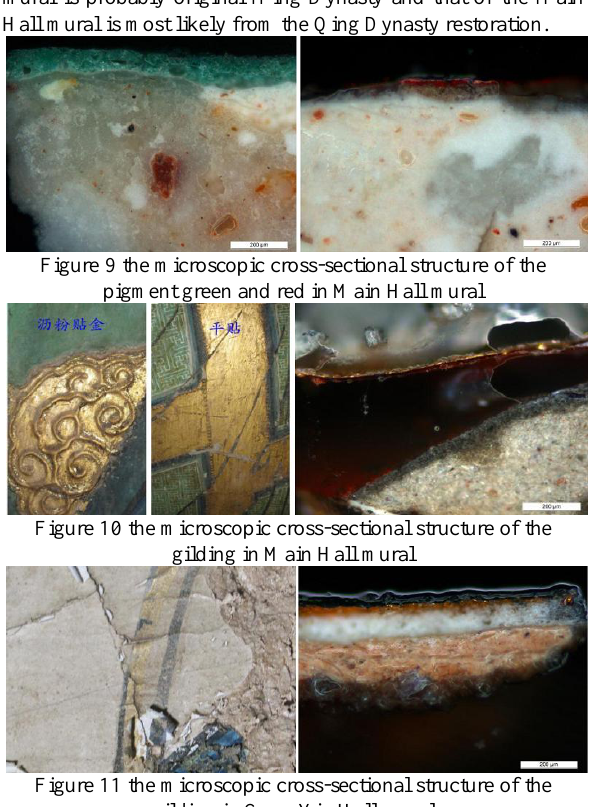
Figure 12 hyper-spectral shooting area of green